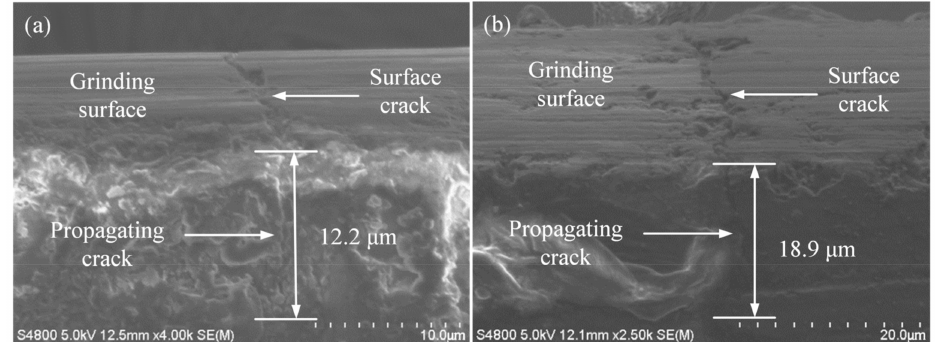
Figure 4. Influence of grinding depth on crack propagation ( v s = 38 m/s, v w = 3500 mm/min):